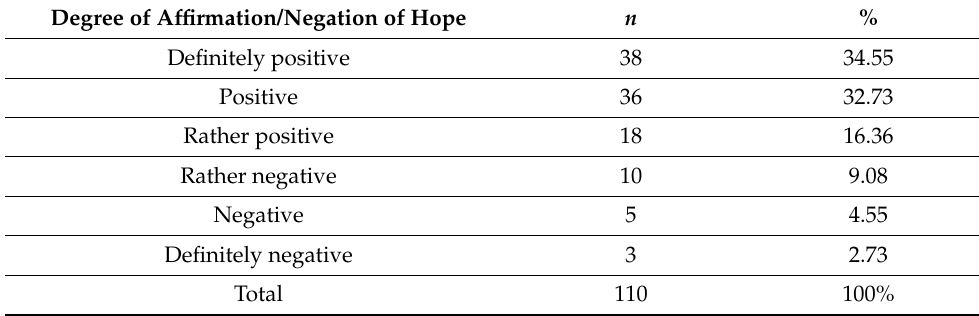
Table 2. The degree of affirmation/negation of hope in the cognitive aspect presented by men in the terminal stage of cancer ( n =